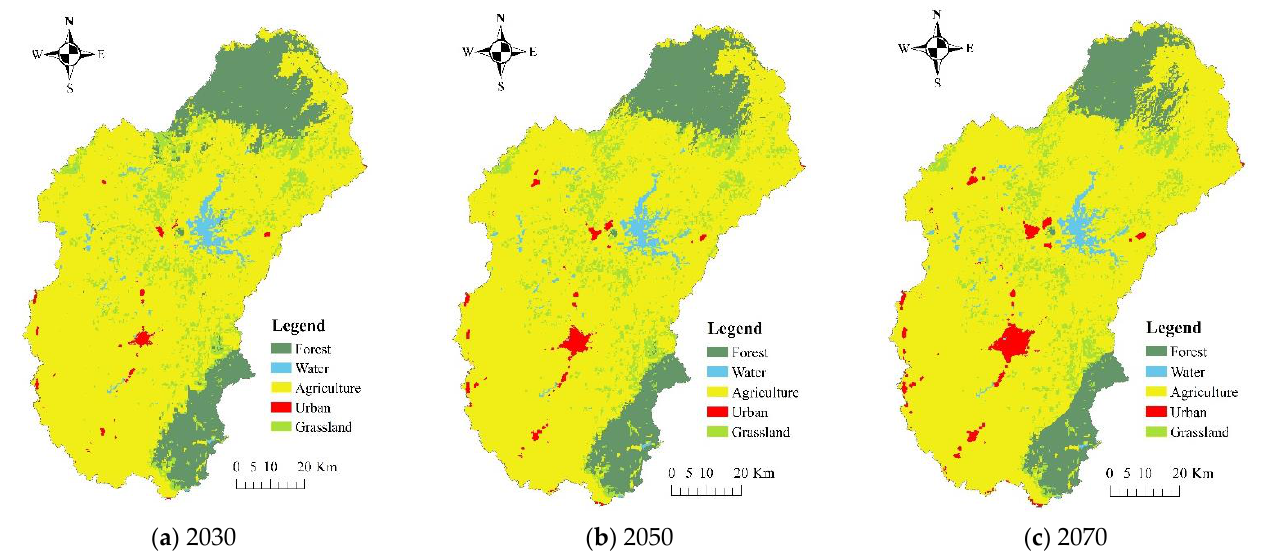
Figure 5. Projected LUC maps in ( a ) 2030, ( b ) 2050, and ( c ) 2070 for the study region.